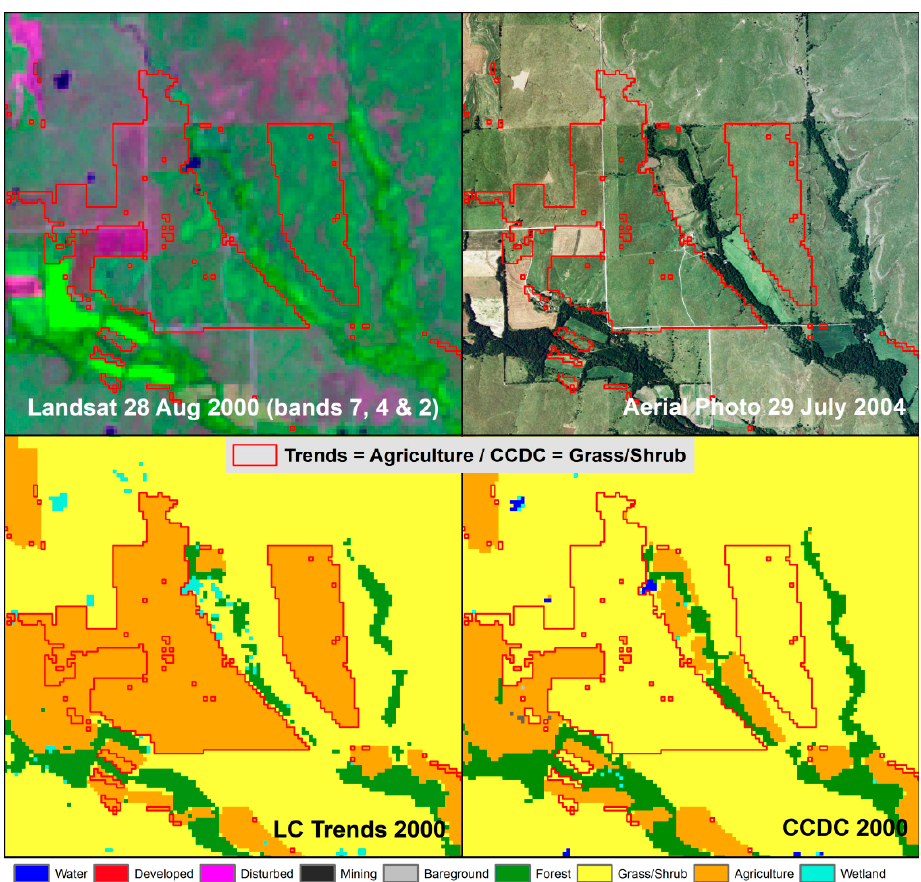
Figure 6. The red polygons delineate areas of pasture mapped as Agriculture by LC Trends and Grass/Shrub by CCDC.